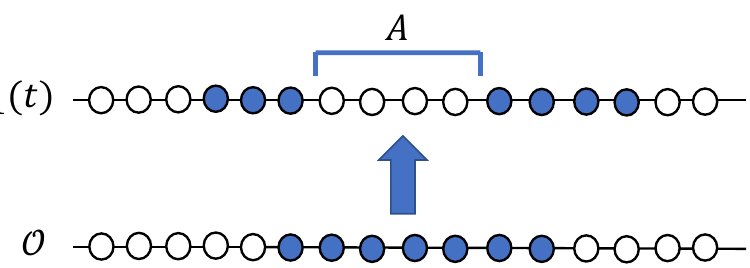
Figure 1 . An operator O in a many-body system can develop a “void” under time evolution, where nontrivial parts of O 1 ( t ) (introduced in (1.1)) are separated by a region of identity operators. In the example shown above in one spatial dimension, the operator has nontrivial single-site operators at blue sites, and the identity at white